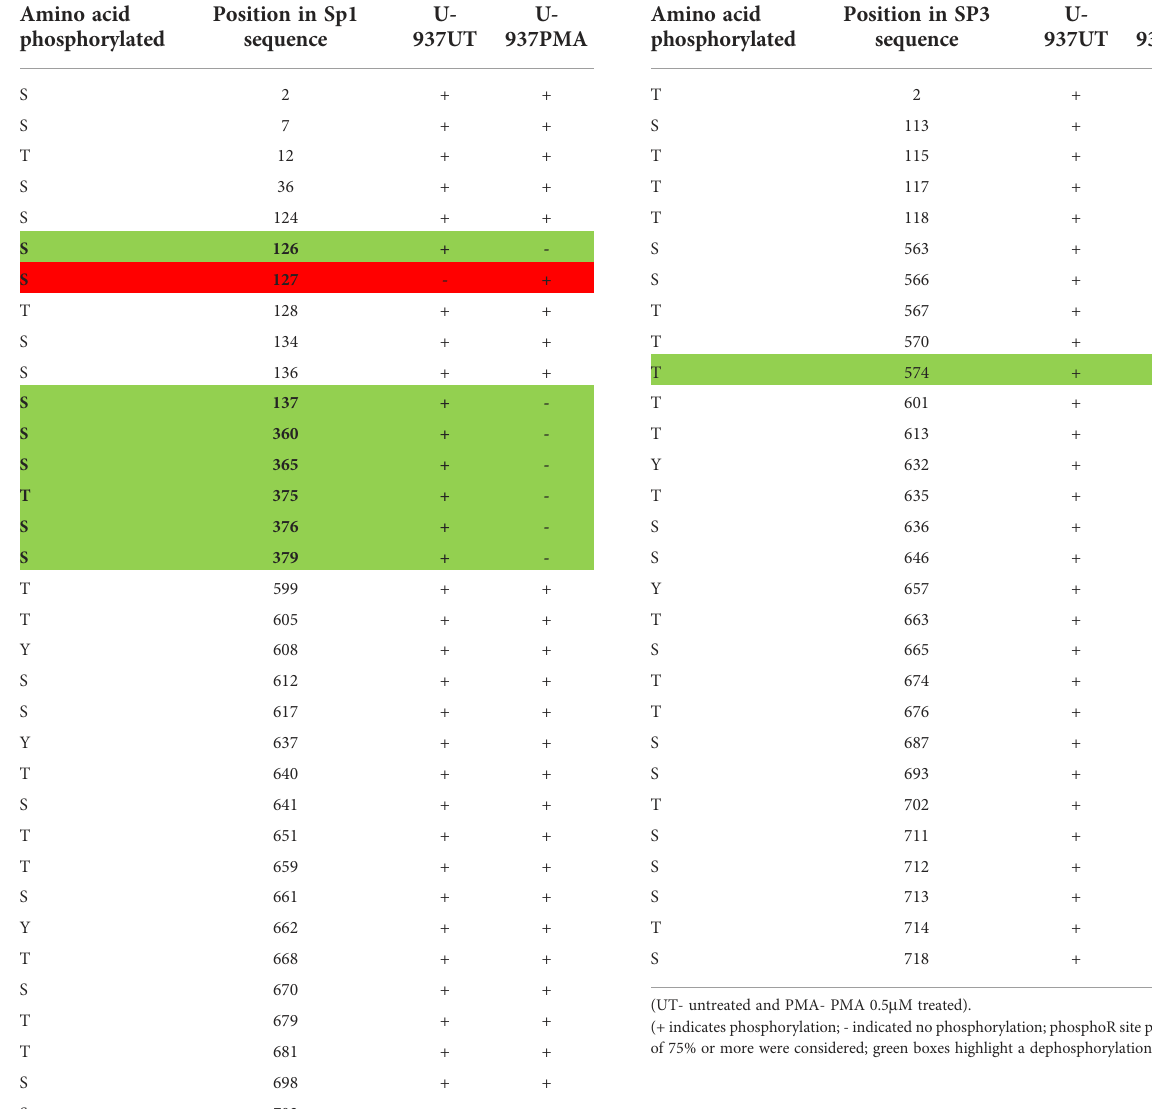
TABLE 1 PTM (phosphorylation) analysis on Sp1 in promonocytic U-937 cells upon PMA stimulation. Amino acid phosphorylated